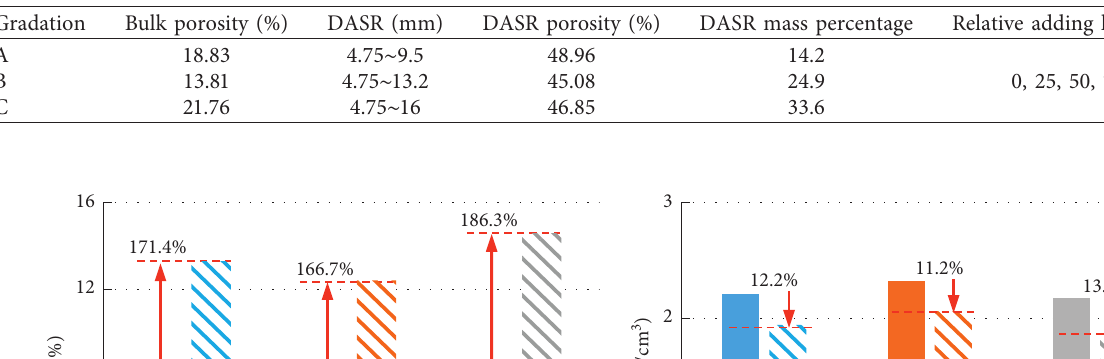
Table 5: Mix design by adding limestone.